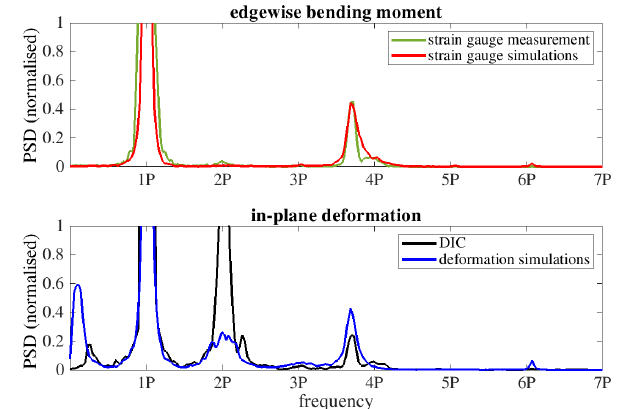
Figure 28. Comparison of PSD extracted with Welch’s method for edgewise and IP signals of blade